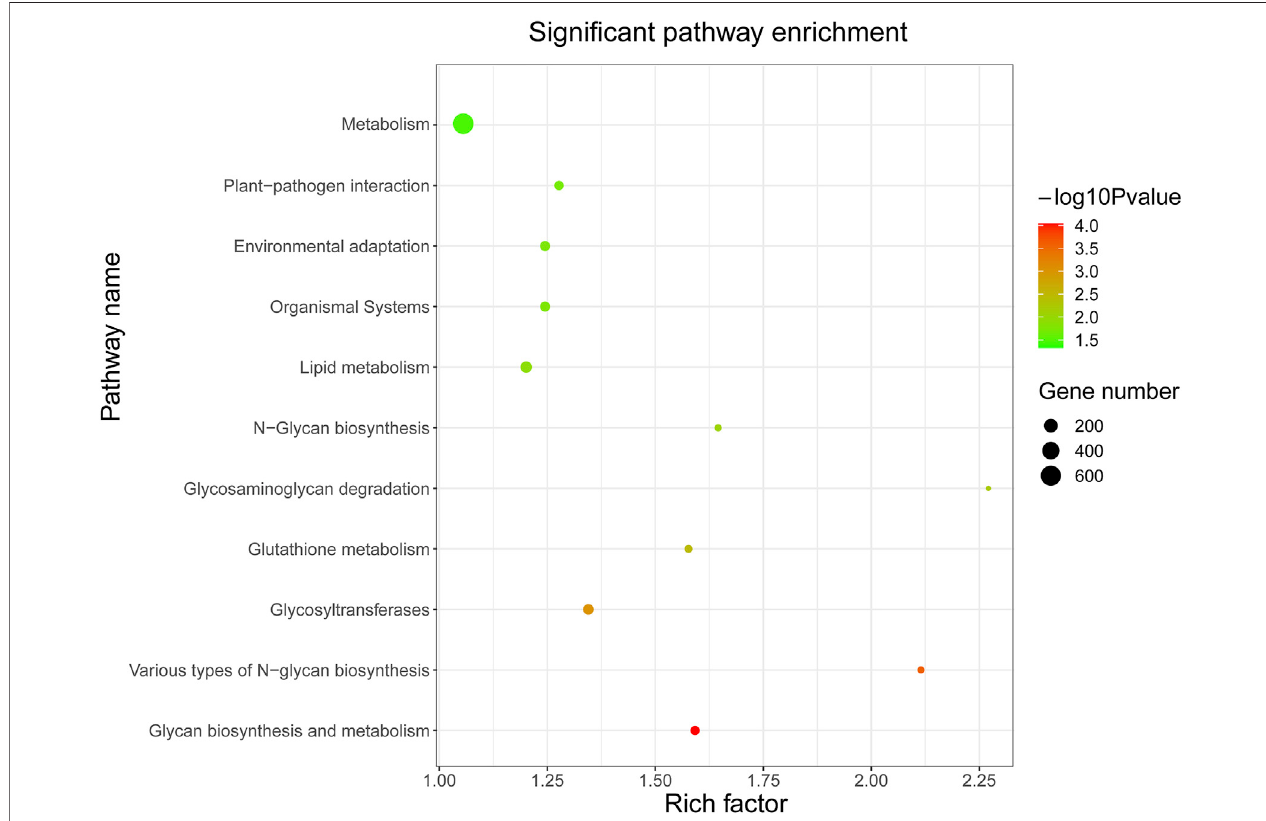
FIGURE 6 | KEGG pathway enrichment analysis of predicted putative target genes of KoWRKYs in K. obovata . The coloring of the q-values represents the signi fi cance of the matched gene ratio; the circle size represents the target gene number.